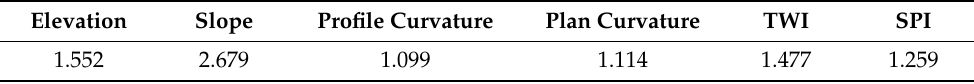
Table 2. Evaluation of vulnerability according to area under the curve (AUC).